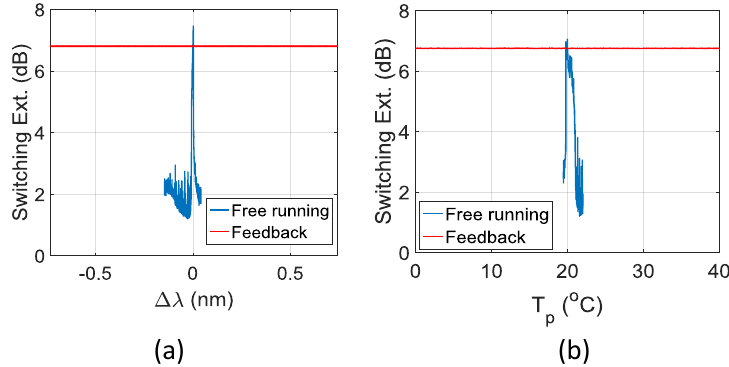
Figure 10. Measured switching extinction ratio as a function of ( a ) laser detuning from the optimal free running bistable setpoint; and ( b ) temperature of the Peltier